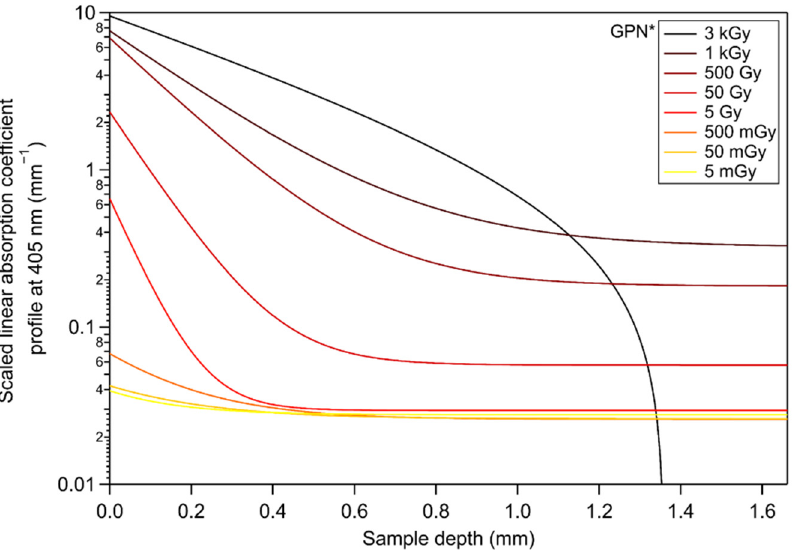
Figure 5. Estimated depth-dependent profiles in absolute values of the linear absorption coefficient at 405 nm.